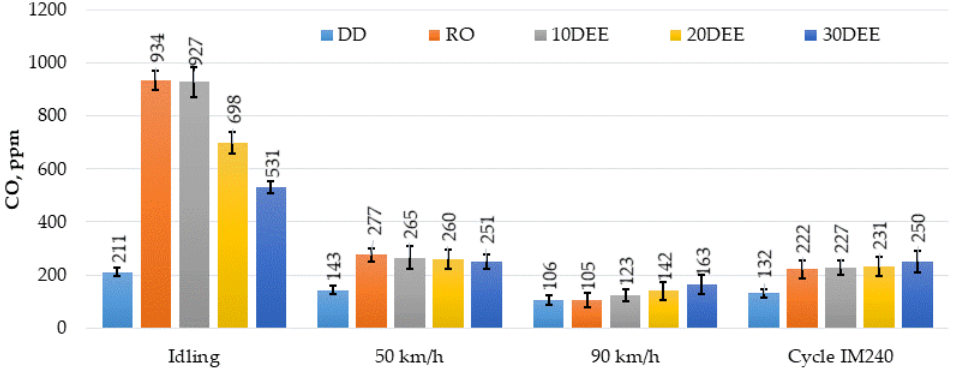
Figure 5. CO emissions of DD, RO, 10DEE, 20DEE and 30DEE in different testing conditions.